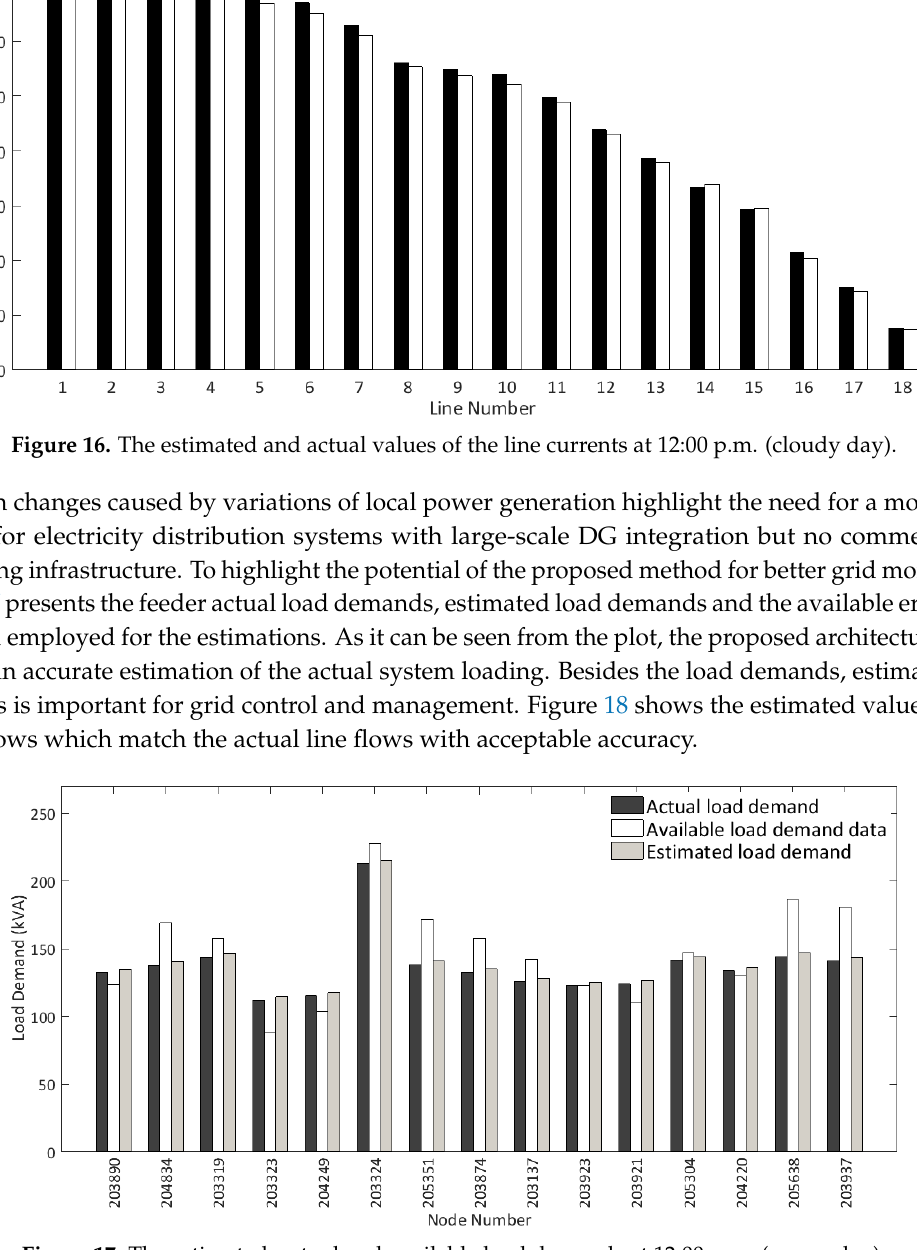
Figure 17. The estimated, actual and available load demands at 12:00 p.m. (sunny